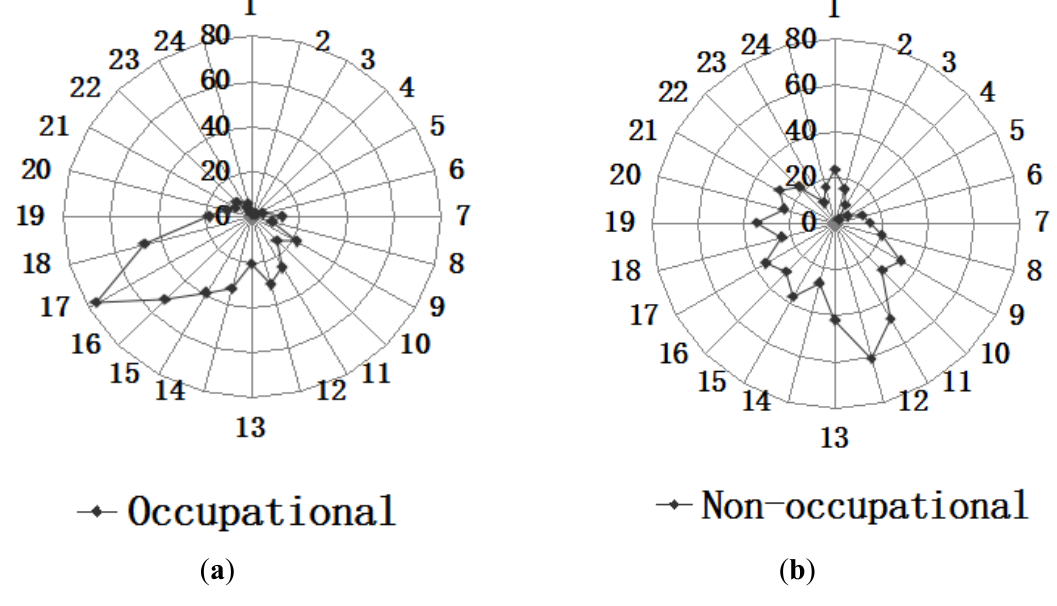
Figure 2. Seasonal distribution of occupational and non-occupational eye trauma.